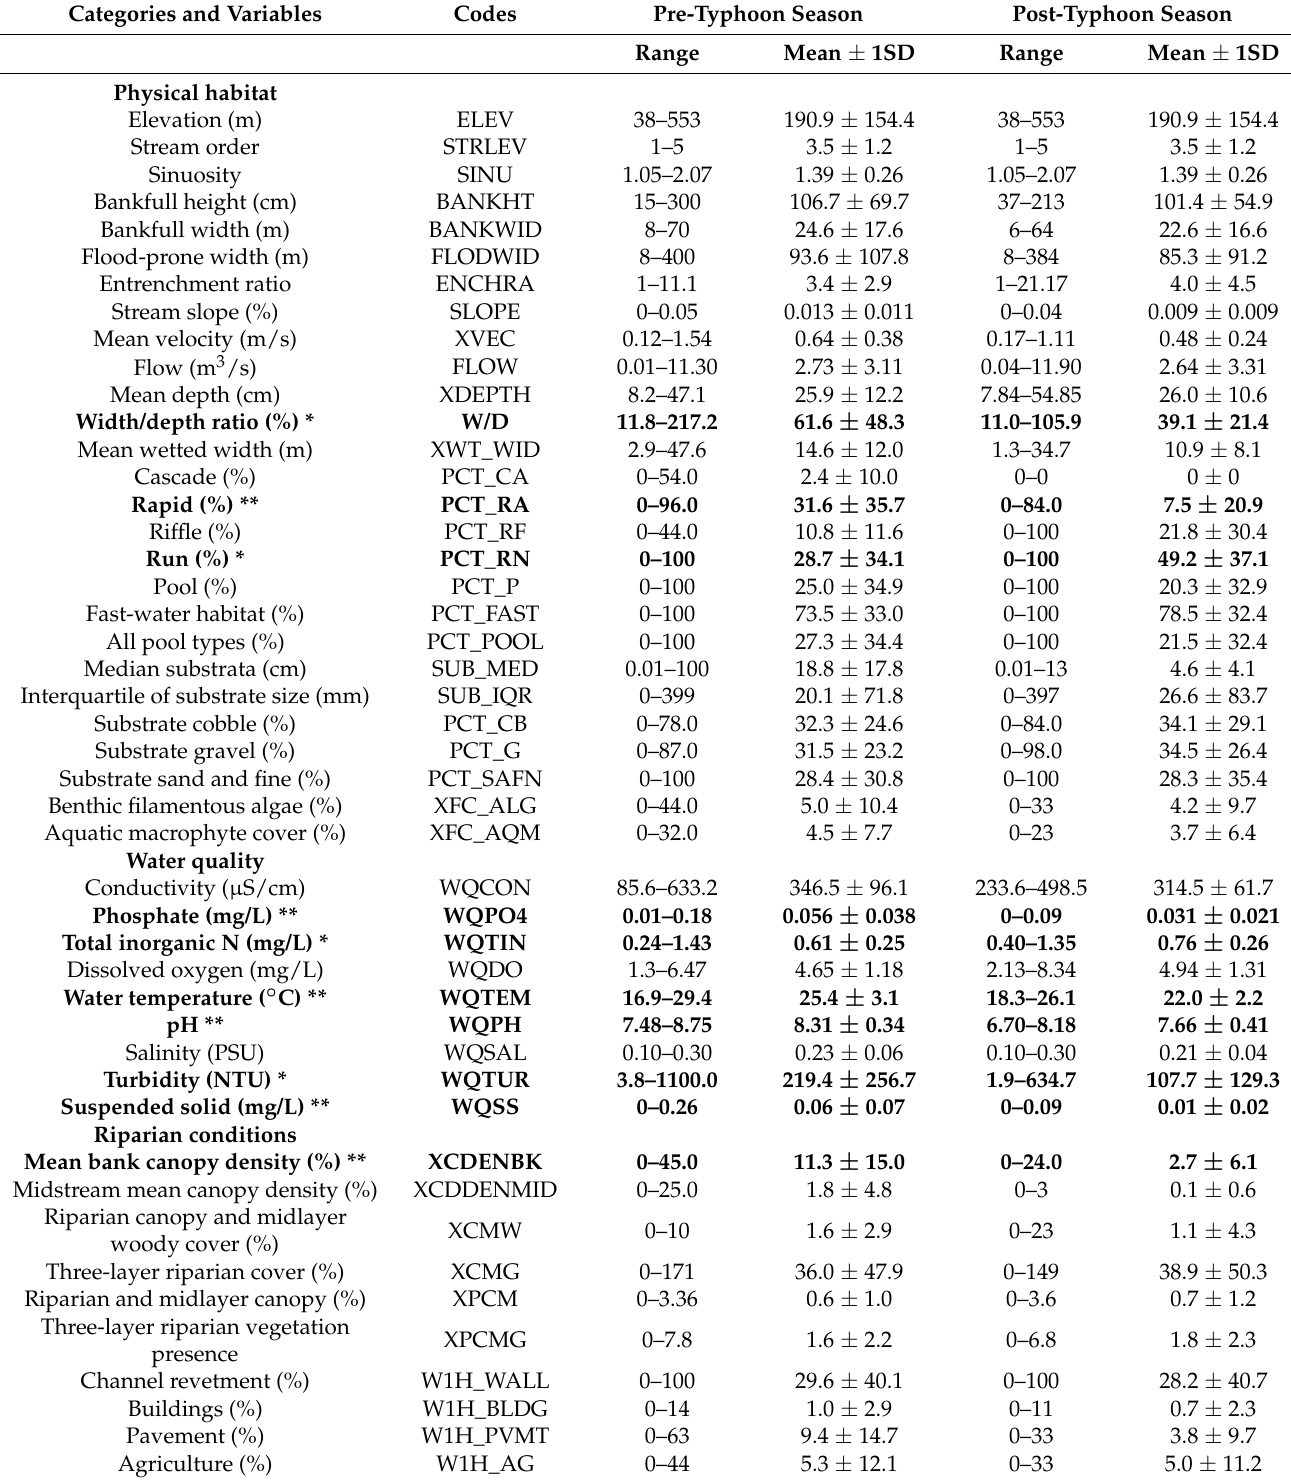
Table 2. The range, mean, and standard deviations of instream physicochemical and riparian land-use measures. ** indicates a significant difference at p < 0.01, and * indicates a significance at p < 0.05 by the paired t -test between pre- and post-typhoon seasons (also shown in